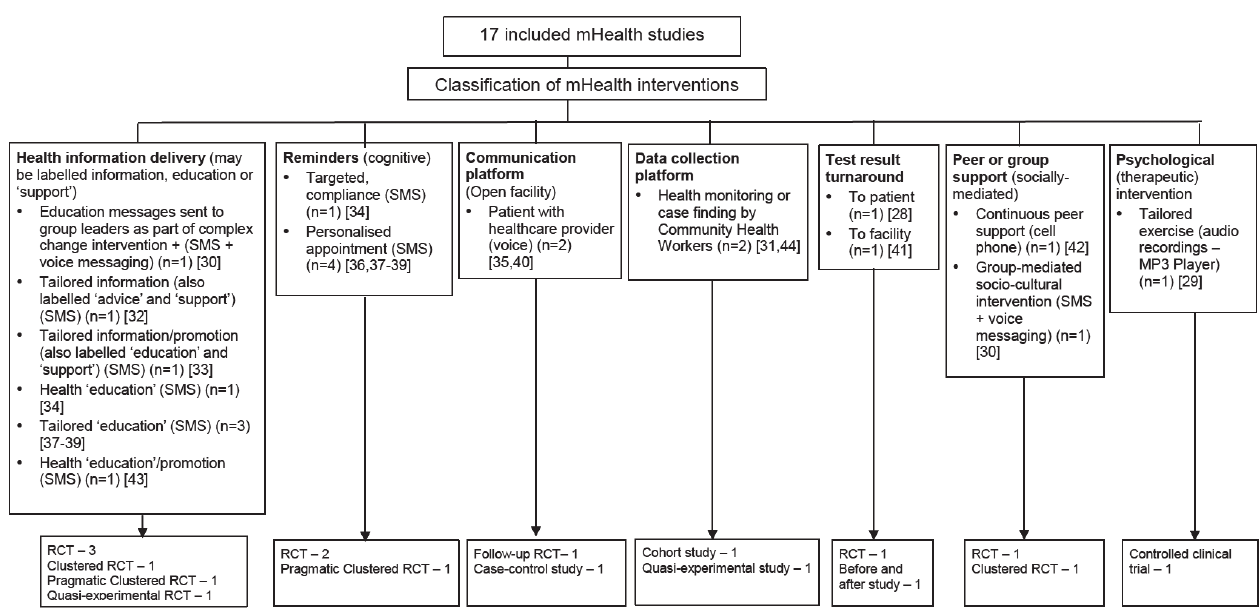
Figure 2. Classification of mHealth interventions of included studies. Categories are as interpreted by the reviewers, based on study descriptions. The authors may label studies somewhat differently. For example, the word ‘support’ may be used to describe informa- tional messages, such as where it is theorized that these may confer psychological support in addition to knowledge support (eg, knowing that it is normal to experience morning sickness), although rarely do the authors elaborate on this. Studies are included in more than one category if the intervention is